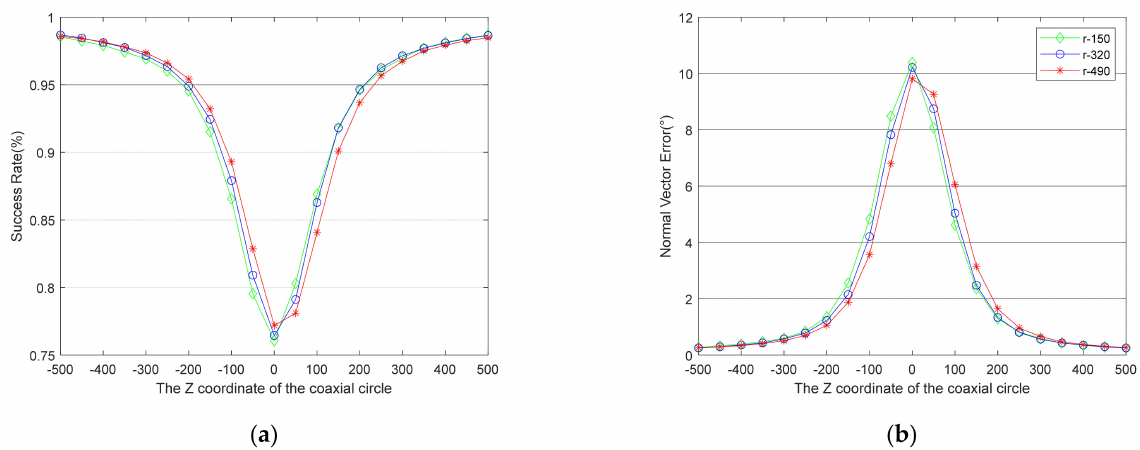
Figure 8. This is a figure about the relationship between the performance of the proposed algorithm and the target’s spatial structure when the z -axis coordinate of the drogue is 9 m. ( a ) The curves of the success rate. ( b ) The curves of the normal vector’s angle